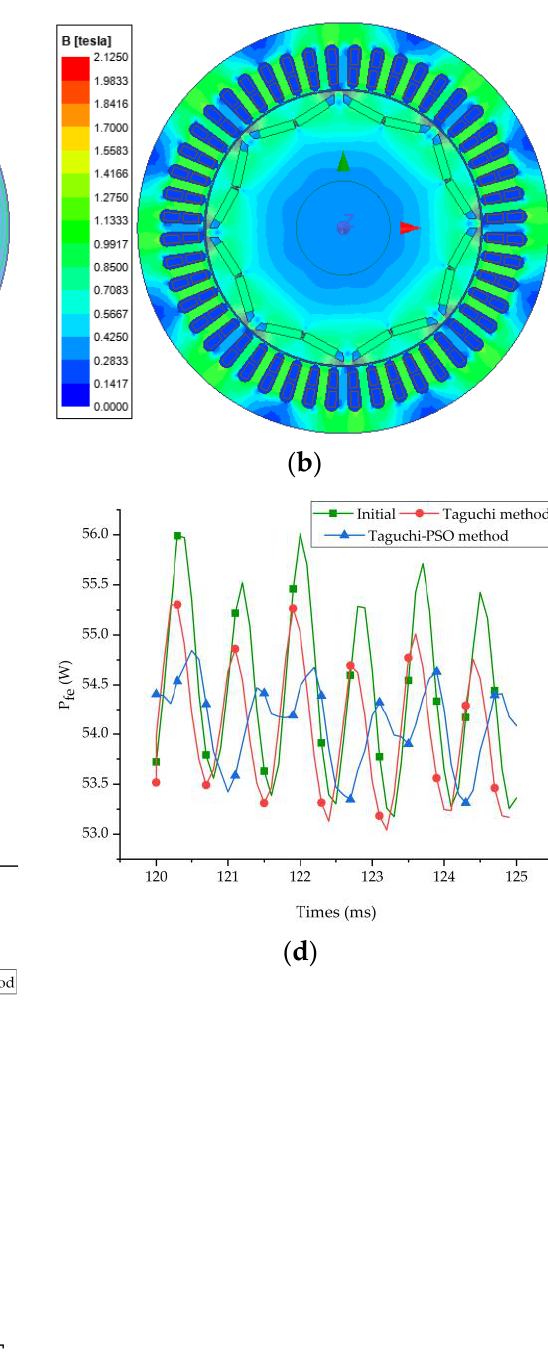
core loss; ( e ) comparison of copper loss. loss; ( e ) comparison of copper